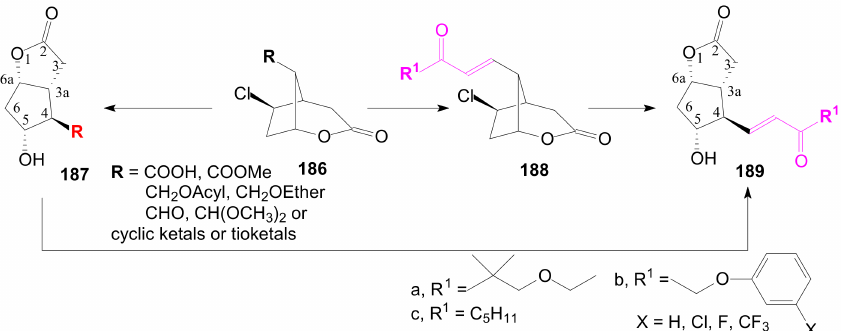
diates 188 and 189 . In pink are presented the ω -side chains, where the modifications are made in this